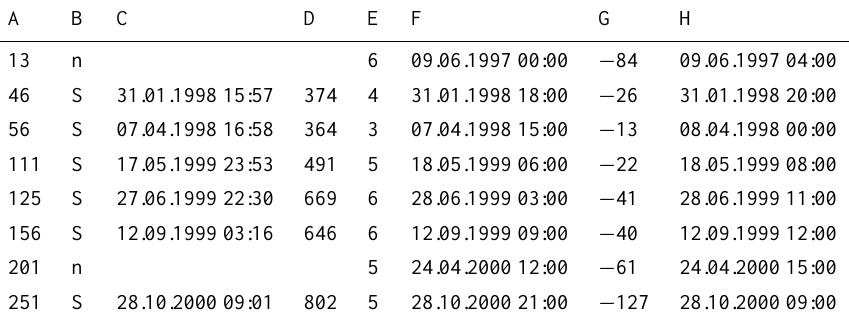
Table 4. The 6 shock and 2 storm events definitely not associated with any CME on the front side or near the limbs within a 120-h time window. The meaning of the columns: ( A ) number of events in catalog at http://star.mpae.gwdg.de/cme effects/, ( B ) S stands for shock occurrence, n stands for definite absence of shock or ICME, ( C ) time of shock arrival, ( D ) local shock speed, in km/s, ( E ) K p maximum in succeeding storm, ( F ) time of K p maximum, ( G ) D st minimum in succeeding storm, in nT, ( H ) time of D st minimum. A B C D E F G H 13 n